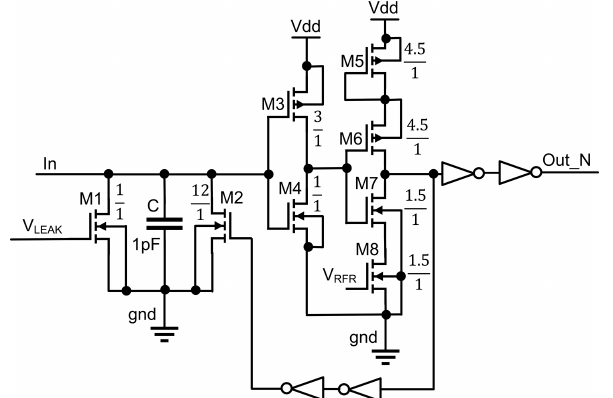
Figure 3. Proposed circuit of analog leaky integrate-and-fire (LIF) neuron (sizes of the transistors are in µm). It is simplified from In- diveri’s neuron by removing the unnecessary components for the target of this work. It is used to implement adaptive coincidence detection (ACD)